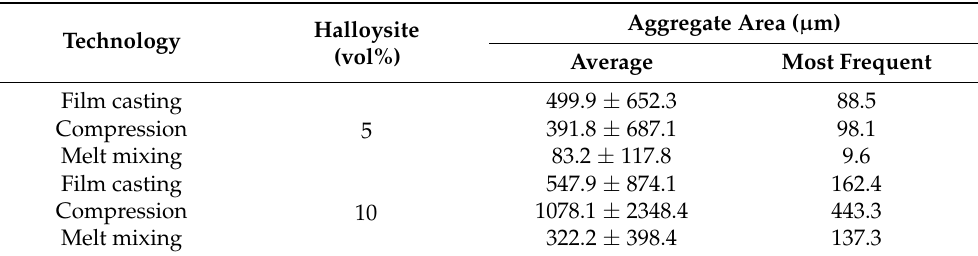
Table 1. Effect of halloysite content and sample preparation technology on aggregation in PCL/halloysite